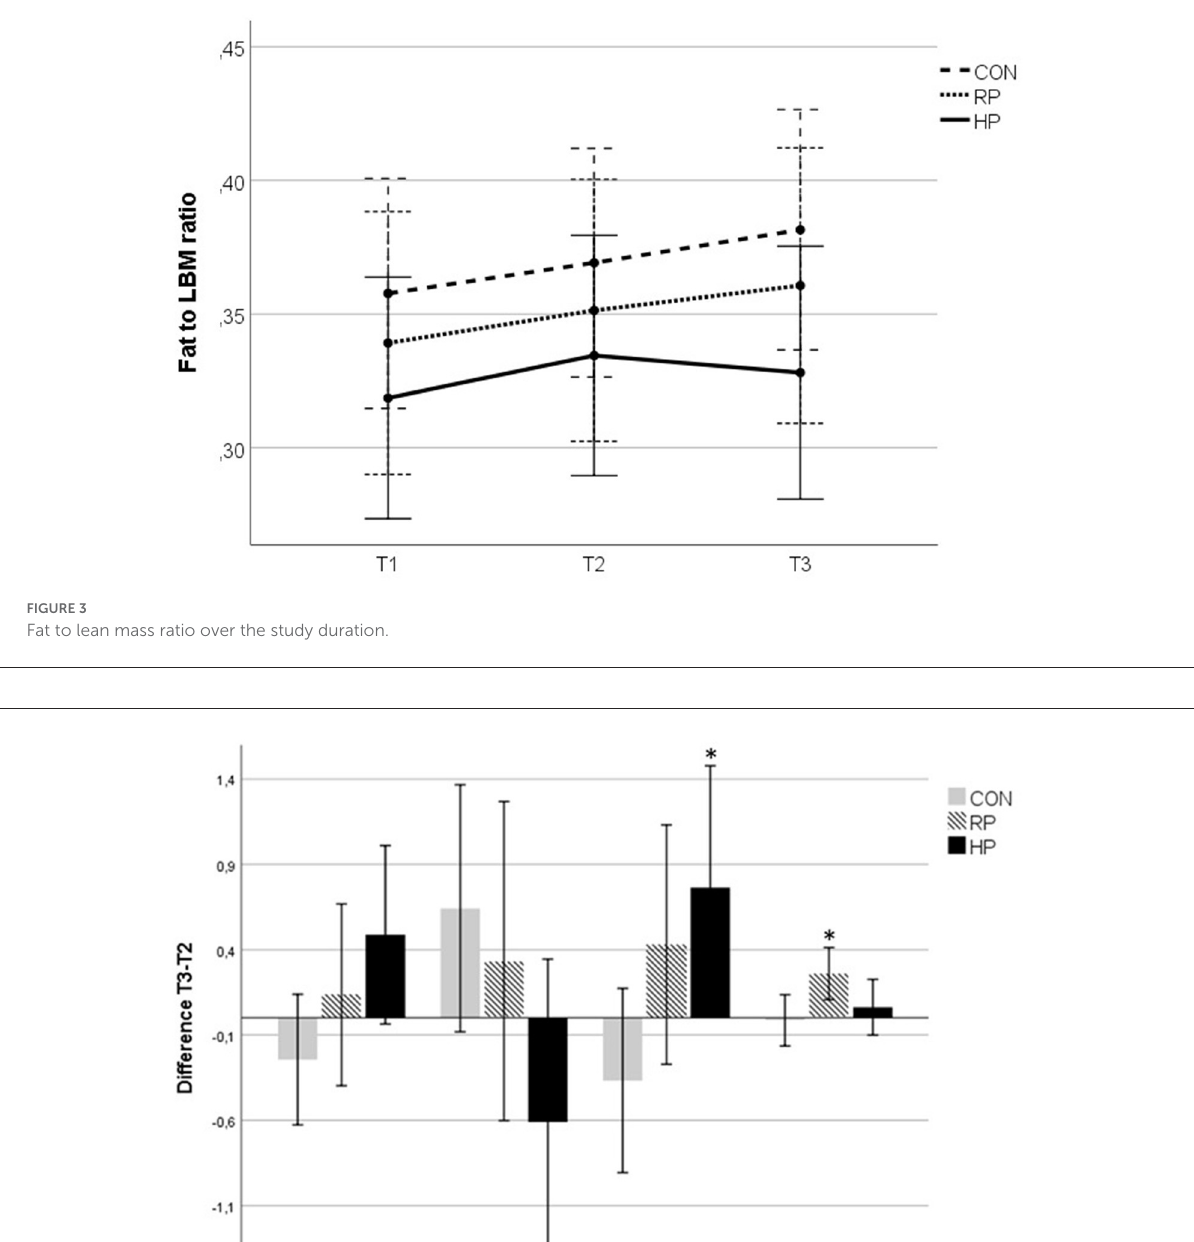
T3 in the high protein group showed hardly any changes in the plasma proteome (Figure 5B). Comparison of protein abundance between T1 and T2 of the recommended protein as well as the control group lead to the identification of 90